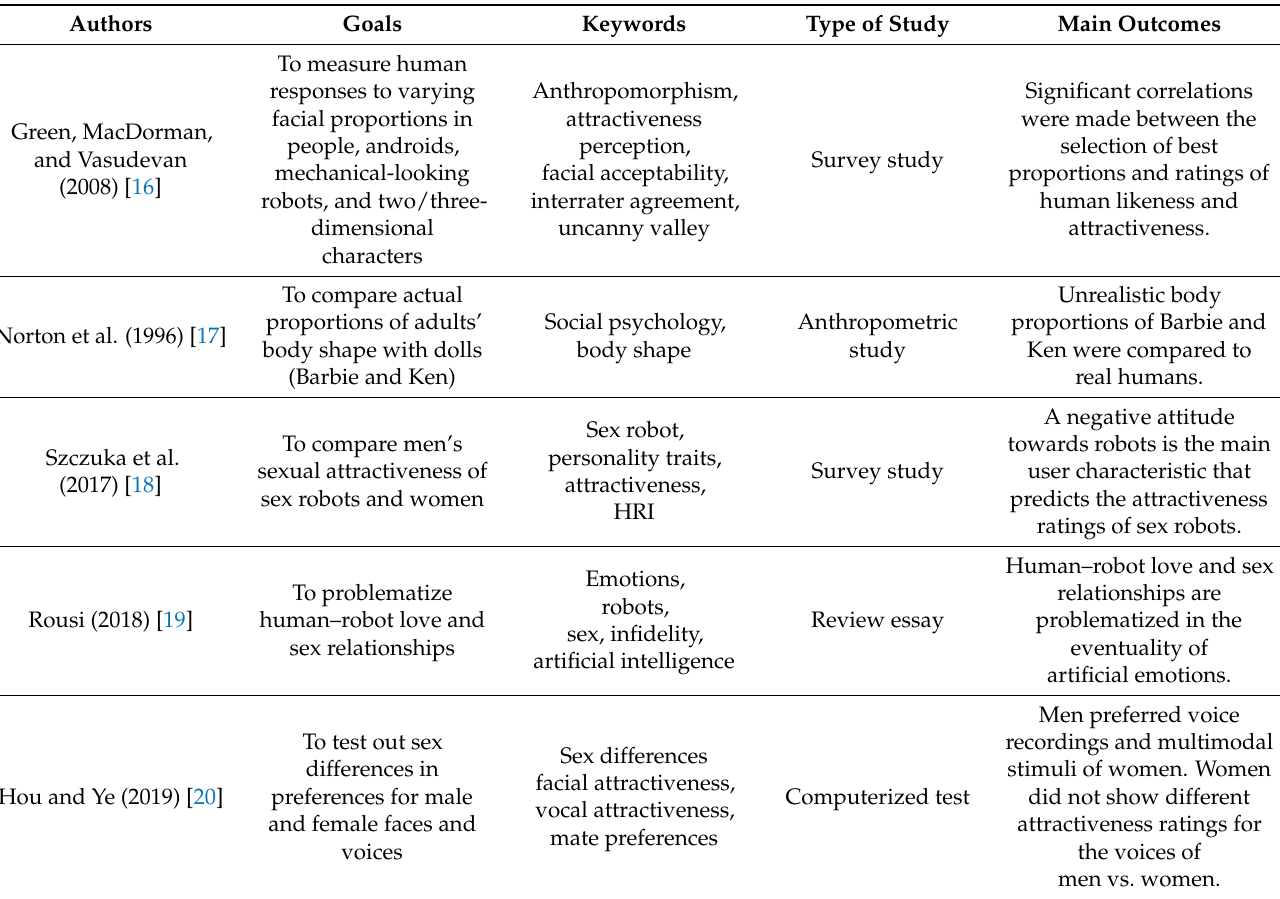
Table 1. Research question 1 (RQ1) about design approaches, type of study, and outcomes.